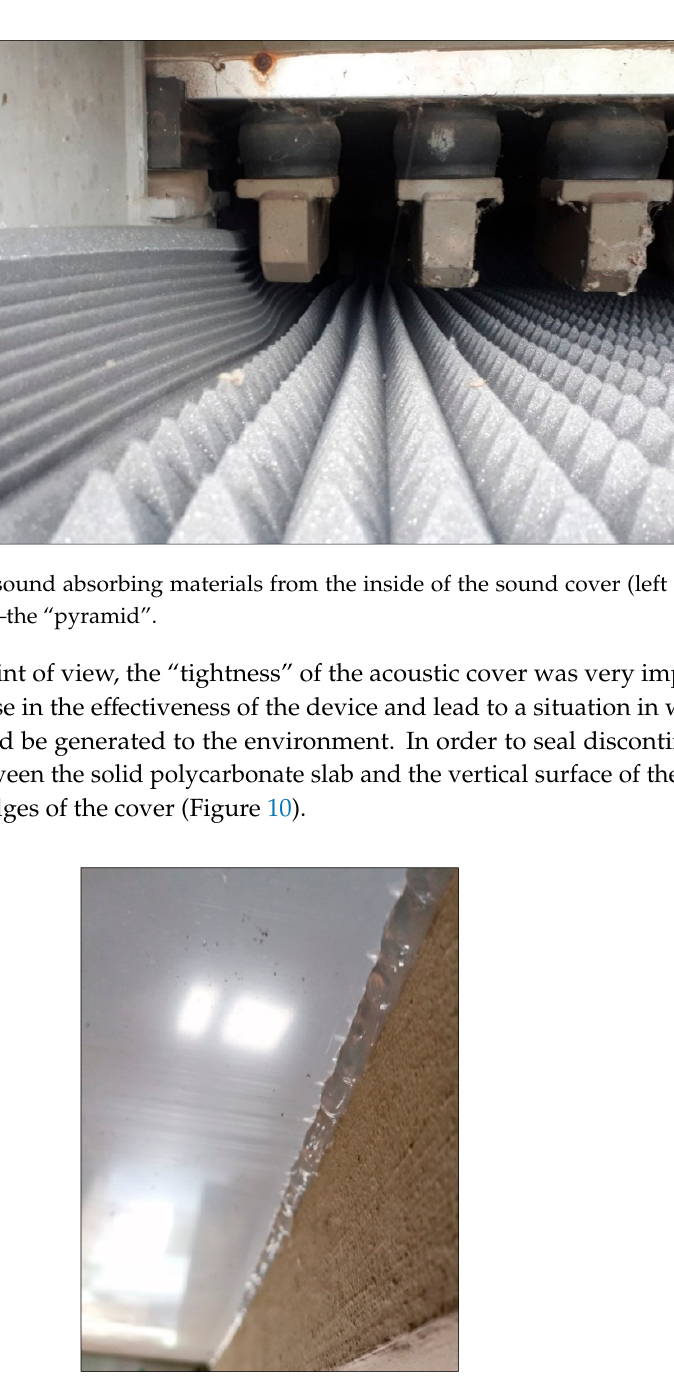
Figure 10. Sealing of the contact between the solid polycarbonate slab and concrete slab of the bridge span with silicone.